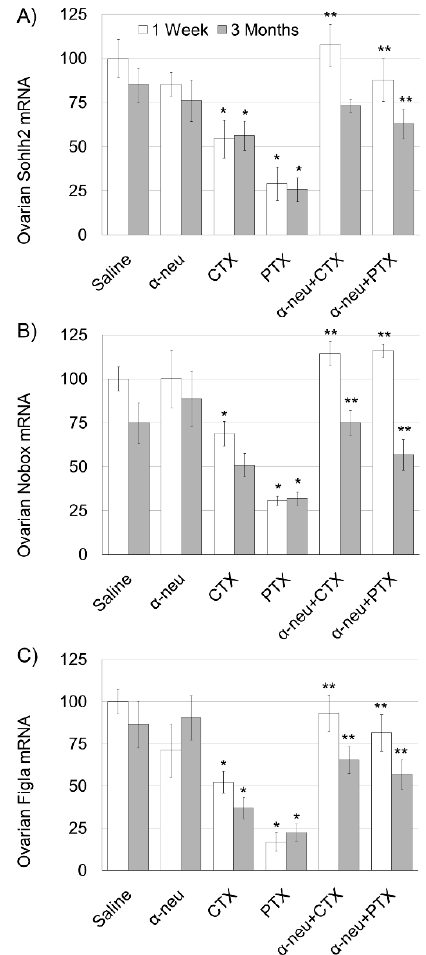
Figure 4. Ovarian reserve in mice after chemotherapy treatment with or without anti-HER2/neu.